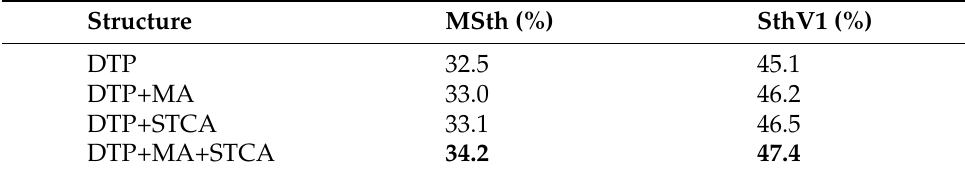
Figure 7. The four kinds of structure for ablation analysis. ( a ) DTP; ( b ) DTP+MA; ( c ) DTP+STCA; ( d ) DTO+MA+STCA. Table 2. Performance of different structures on MSth and